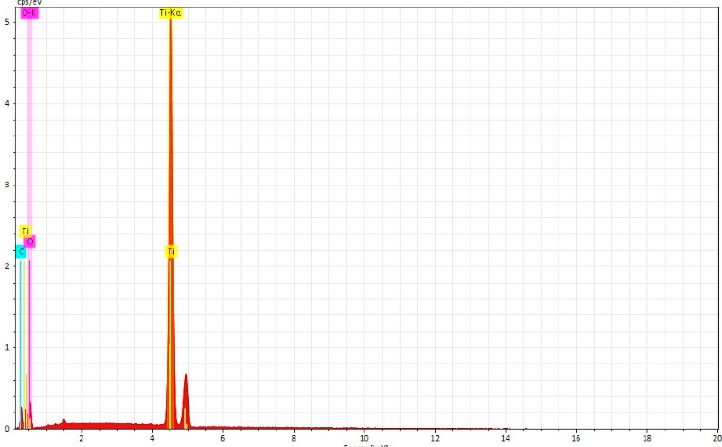
Figure 11. EDS-SEM analysis composition of the non-used Figure 11. EDS ‐ SEM analysis composition of the non ‐ used tappers. Figure 11. EDS ‐ SEM analysis composition of the non ‐ used tappers.